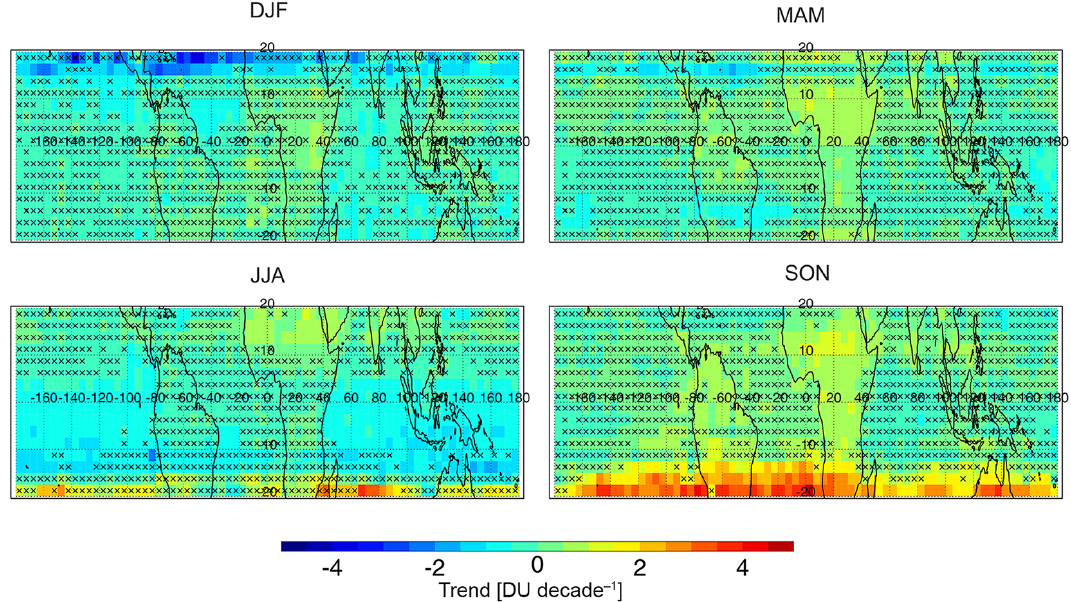
Figure 6. Tropical tropospheric ozone trends for winter (DJF), spring (MAM), summer (JJA) and autumn (SON) for the years 1996 to 2015. Black “ × ” denote statistically non-significant